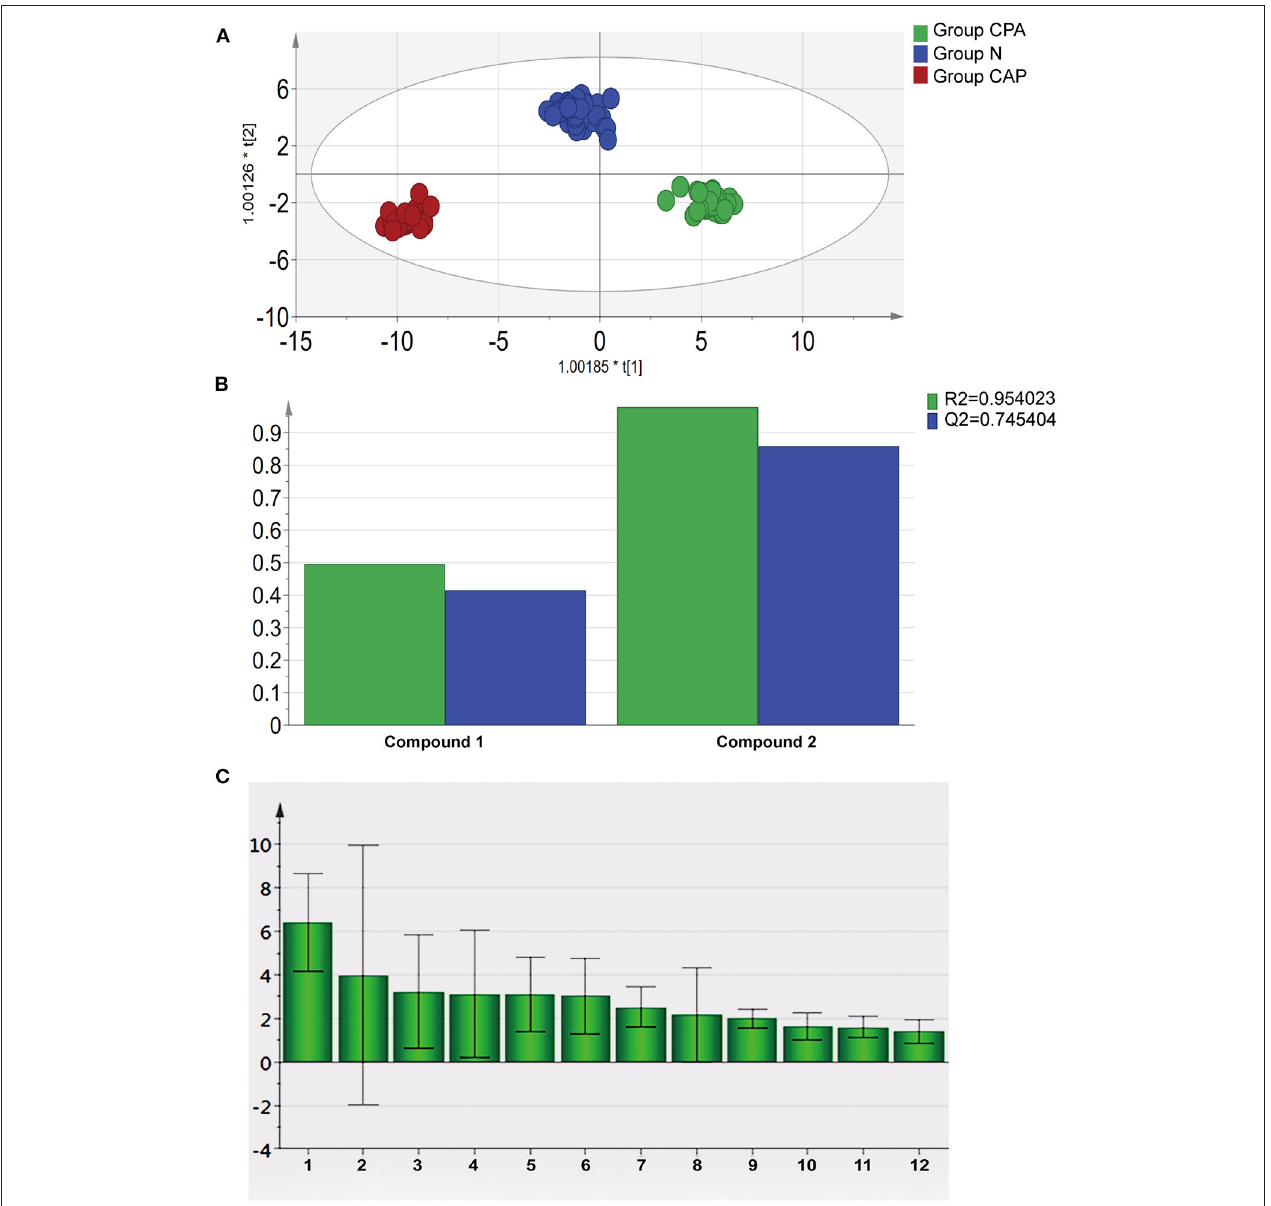
FIGURE 1 | Statistical analysis of characteristic VOCs in exhaled breath of patients with CPA. (A) OPLS-DA score plot of characteristic VOCs in exhaled breath samples in group CPA, group CAP and group N. (B) Parameters of the OPLS-DA model of characteristic VOCs in exhaled breath samples in group CPA, group CAP and group N. (C) VIP value of characteristic VOCs in exhaled breath samples of patients with